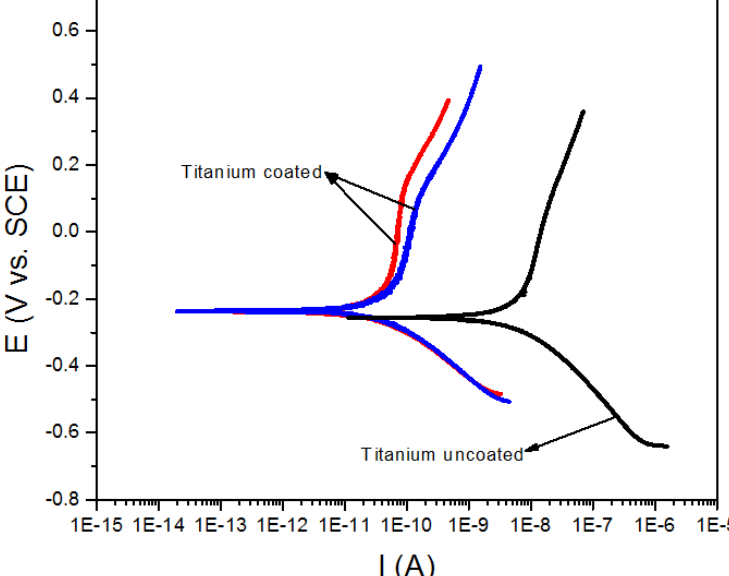
Figure 9. Potentiodynamic polarization curves recorded from the titanium alloy (Ti coated (Blue and red lines) and uncoated (Black line).